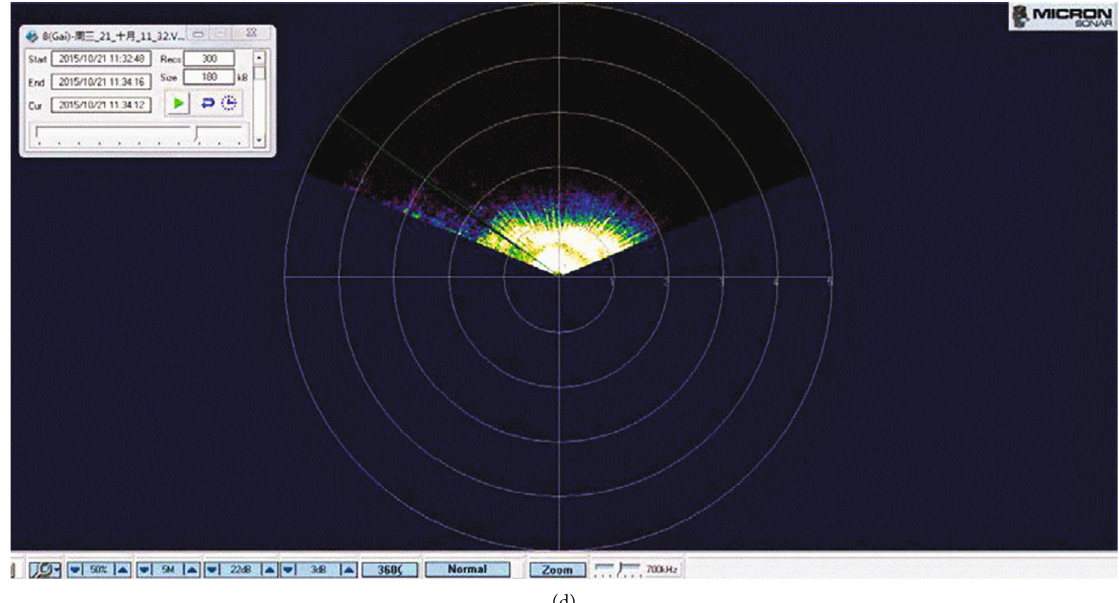
Figure 12: Sonar sensor detection used to identify the environment. (a) Structure diagram of sensor placement. (b) E ff ect diagram of sensor detection. (c) Micron DST SONAR S08725. (d) Measurement of the depth of the underwater